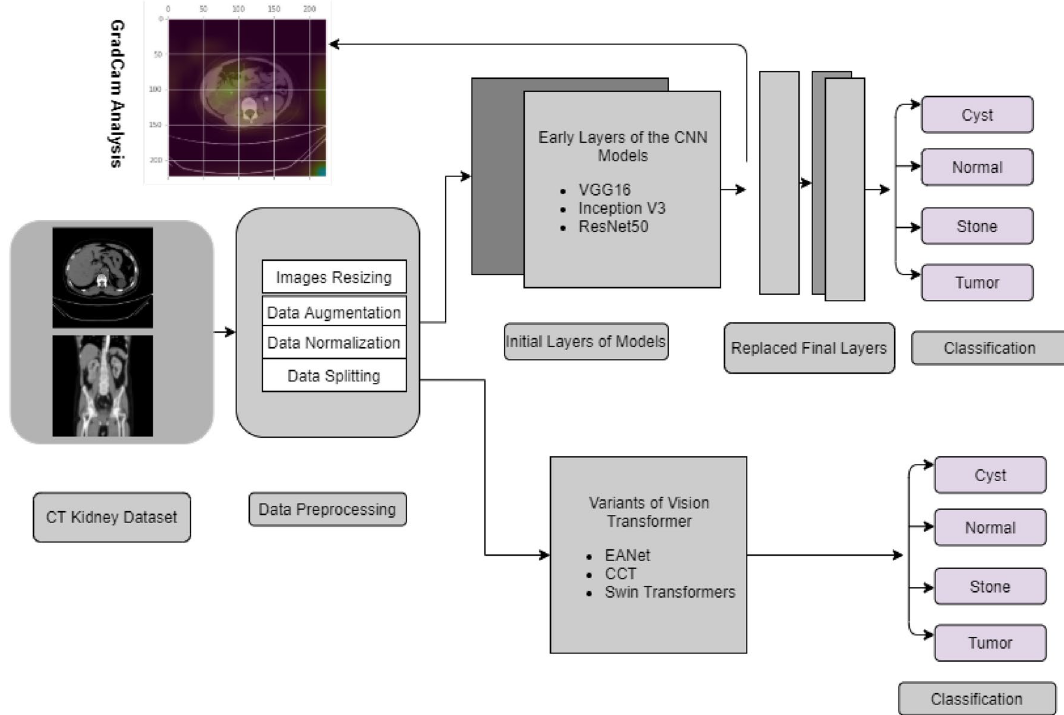
Figure 1. Complete Block Diagram of Experiments to diagnose Kidney tumor, cyst and